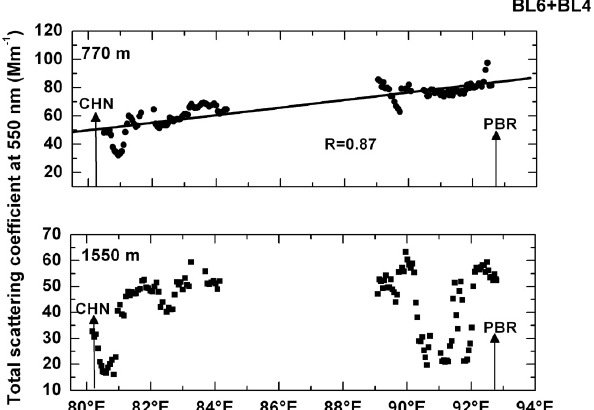
Fig. 13. Latitudinal variation of σ tsc values due north and south of PBR at 770 (upper panel) and 1550m (lower panel) altitudes during the sorties BL3 and BL5. The arrows in both the panels represent the latitude of